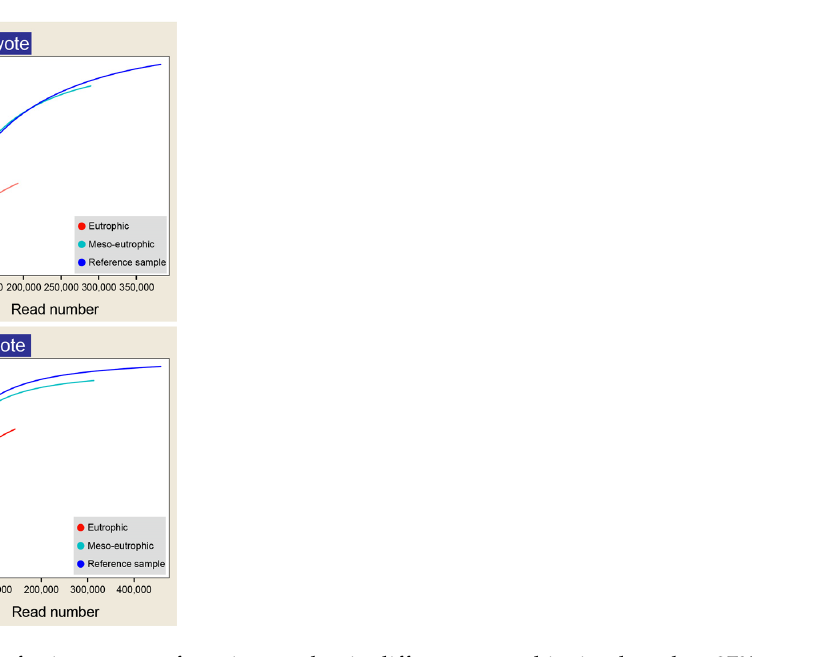
Figure 3. Rarefaction curves of species number in different eutrophic sites based on 97% sequence identity threshold.